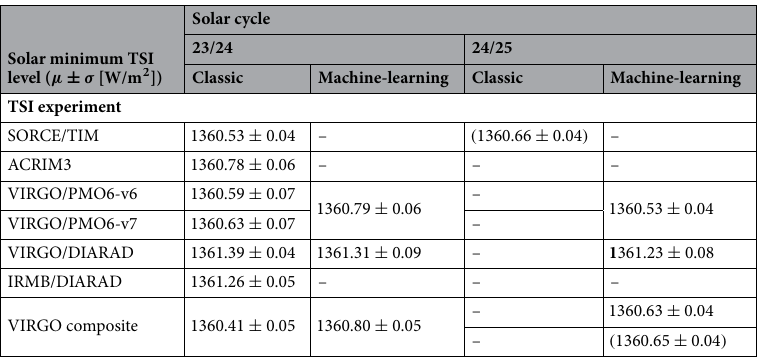
Table 2. Comparison of the TSI levels (mean µ and standard deviation σ ) during the two most recent solar minimum periods between solar cycles 23/24 and 24/25, respectively, as indicated by “LS” and “CS” in Fig. 4. We show the results from various TSI time series produced by PMOD/WRC and other groups (LASP, ACRIM, IRMB) from various missions and experiments. The dash (–) means no estimate is available, “classical” and “machine-learning” refer to the method that was used for correcting the degradation. Note that for easier comparison all TSI values from the VIRGO experiment have been scaled to the “new VIRGO” scale 25 , which 2 means the machine-learning results are offset by − 4.6 W/m compared to those stated in Fig. 4. The SORCE/ TIM time series used in this work ends in February 2020. The cycle 24/25 minimum value for SORCE/ 2 TIM is thus not averaged over the same period as for VIRGO. All VIRGO values would be 0.2 W/ m higher if evaluated over the same period as SORCE/TIM. Values averaged over the shorter time period are put in brackets